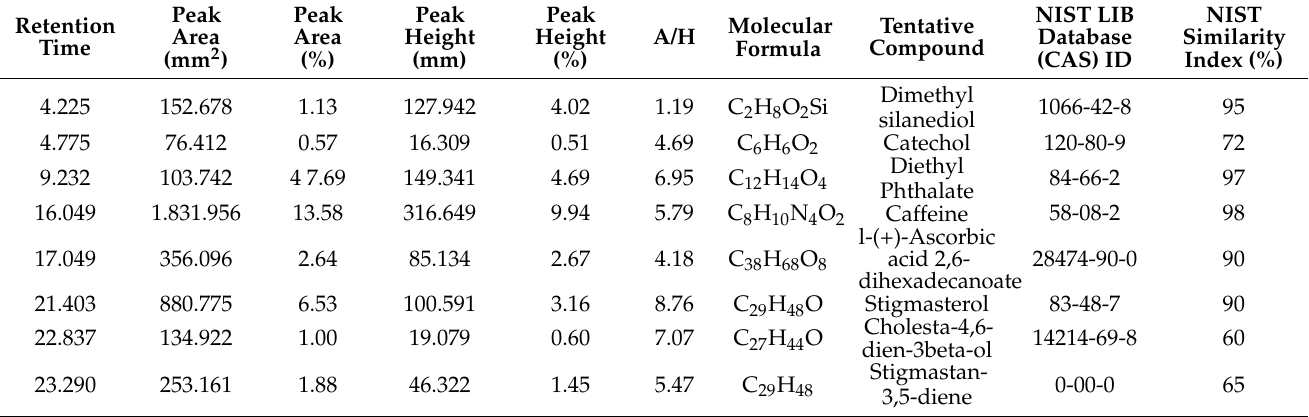
Table 1. Gas chromatography-mass spectrometry (GC-MS)-based tentative identification of components in aqueous extracts of Ocimum tenuiflorum inflorescence. Retention